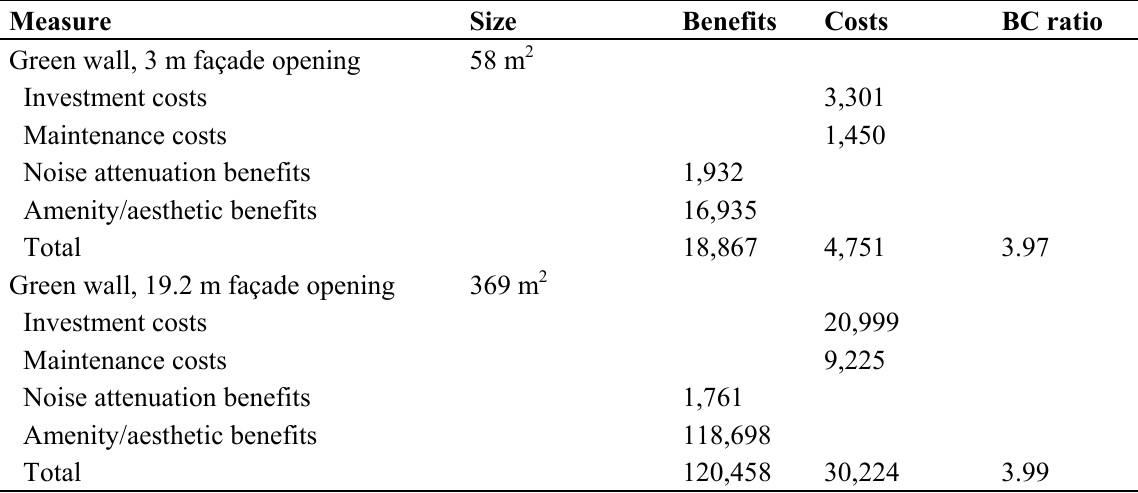
Table 3. Calculation of benefit-cost (B/C) ratios, for the two demonstration projects with differently sized green walls—3 m high and 19.2 m high, assuming a green wall unit price of 2.4 EUR (2010) per m 2 per person per